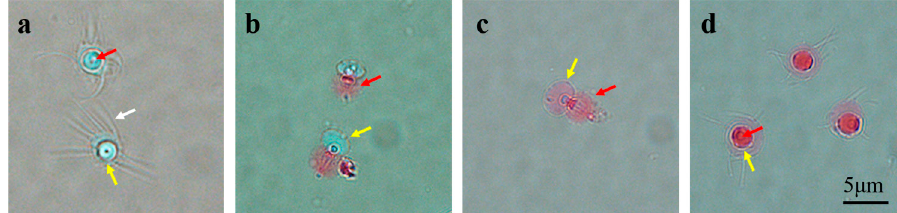
Figure 1. Observation of live and dead sperm under a light microscope at ×1000 magnification. ( a ) Live sperm. ( b ) Live sperm with acrosome reaction. ( c ) Dead sperm with acrosome reaction. ( d ) Dead sperm. Red arrow: acrosome. Yellow arrow: nucleus. White arrow: radical arm.